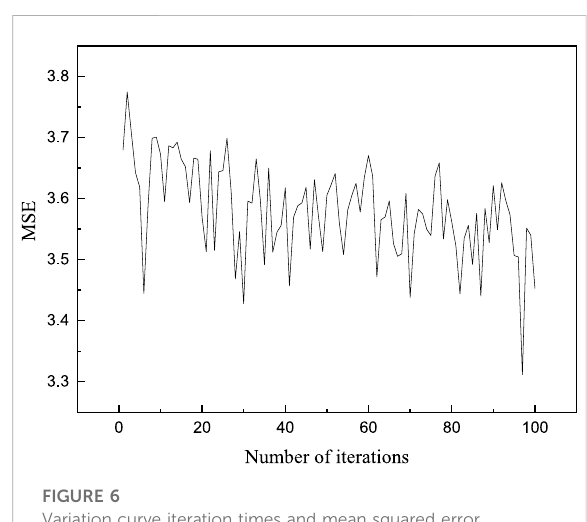
FIGURE 6 Variation curve iteration times and mean squared